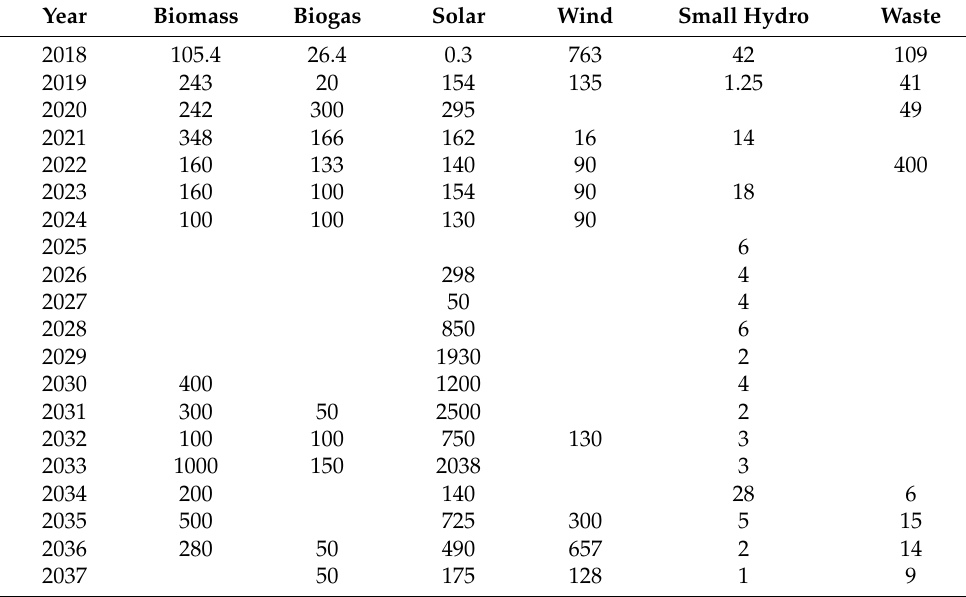
Table A5. Committed renewable generation units